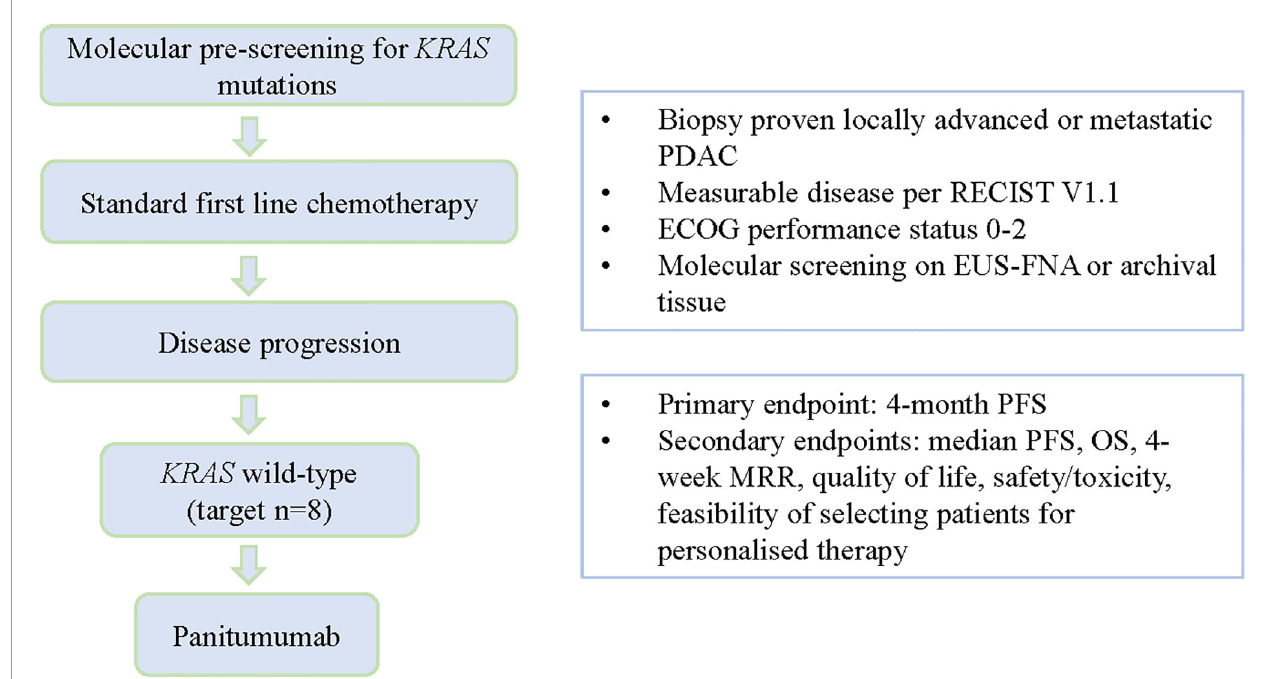
FIGURE 1 | Study schema including key eligibility and response